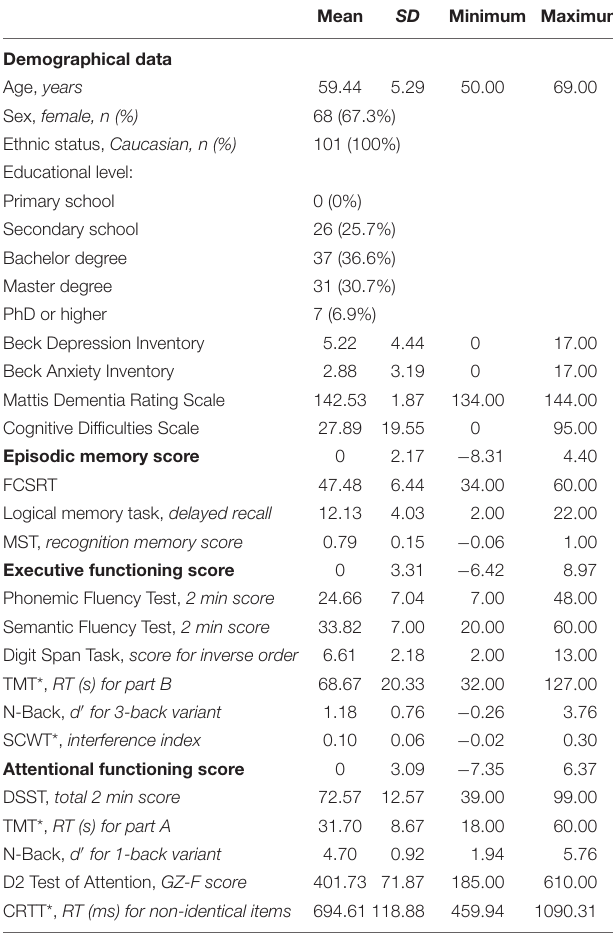
TABLE 1 | Descriptive statistics of demographical data and cognitive outcome ( n =